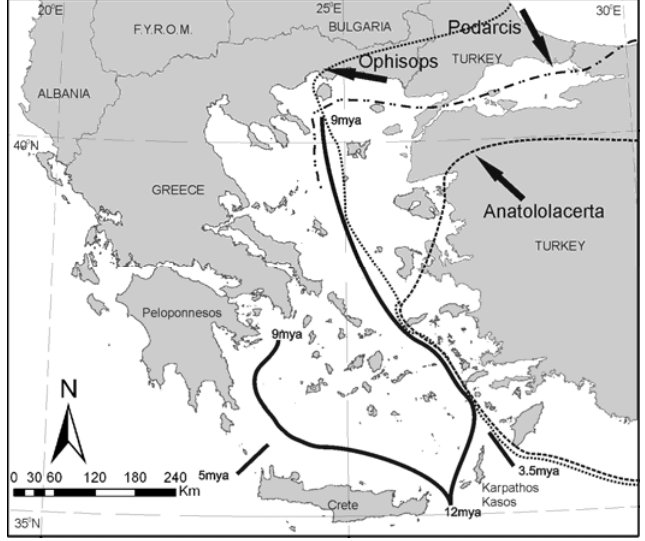
Figure 6. Relative position of the distribution limits of three lacertid genera in the